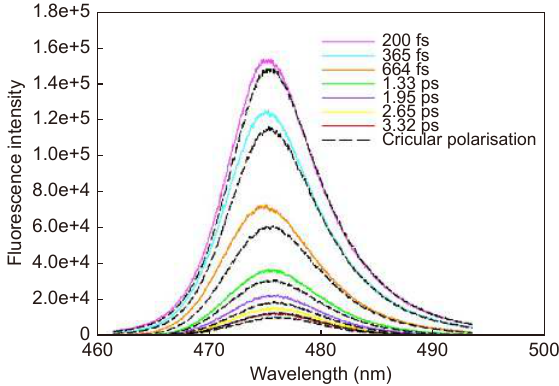
Fig. 13 | Fluorescence signal intensity with linear (solid lines) and circular polarisation (dash lines).